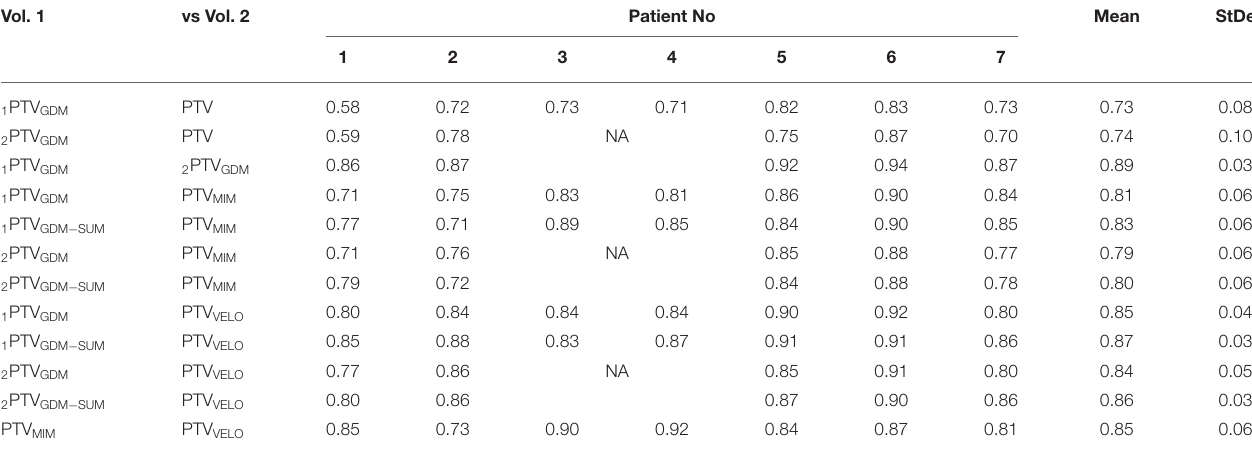
TABLE 4 | Results of relevant volumes mutual comparison in terms of DICE coefficient for 7 patients. Vol. 1 vs Vol. 2